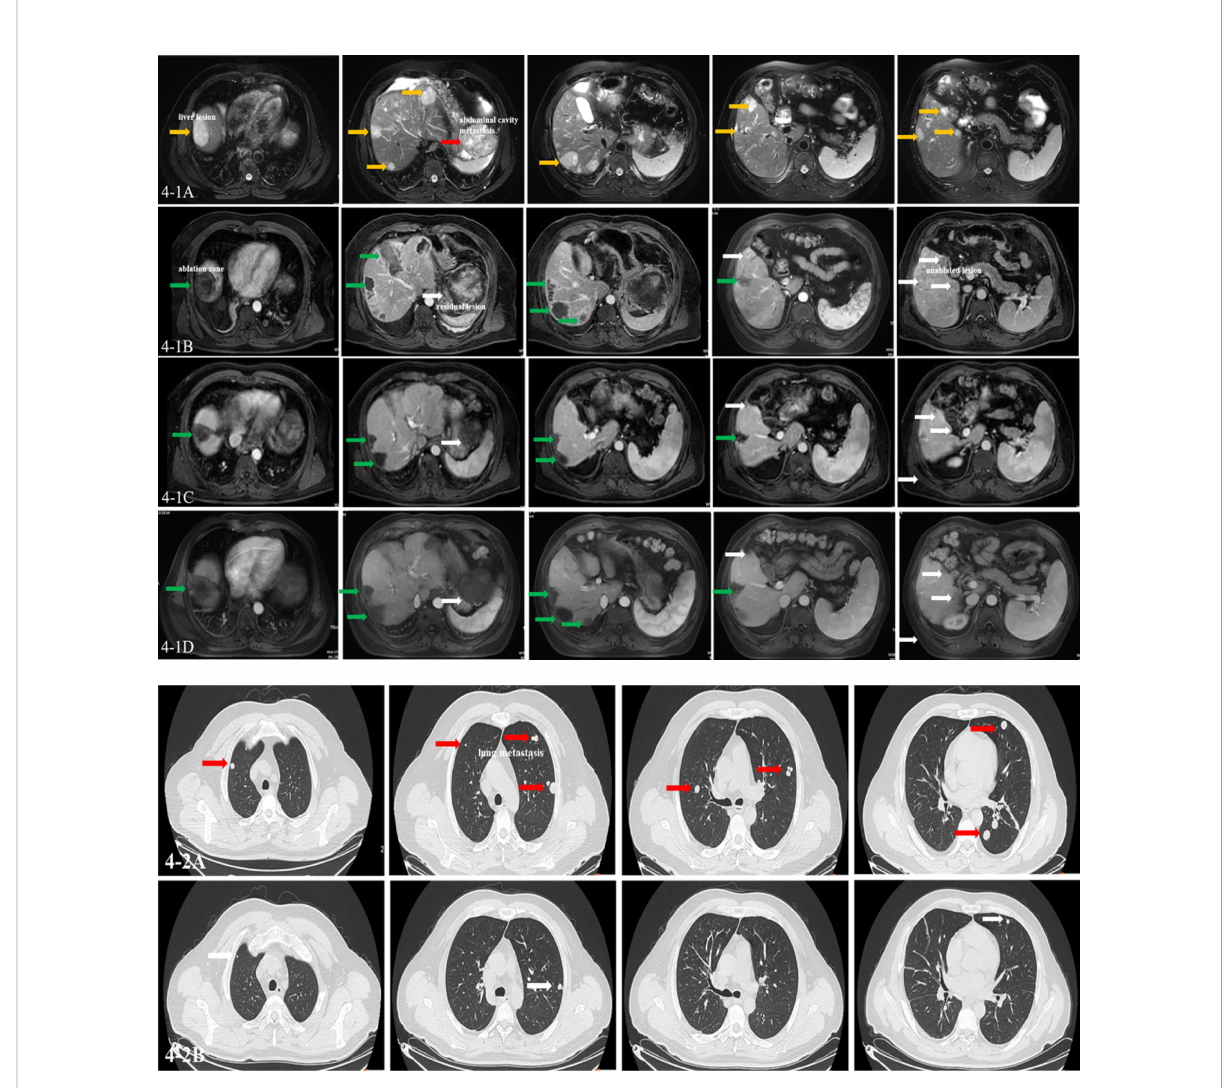
FIGURE 4 Imaging of clinical events. A man aged 45 years was diagnosed as having moderately differentiated hepatocellular carcinoma at Barcelona Clinic of Liver Cancer (BCLC) C stage, who received the combination therapy. (4-1A) The T2 phase of MRI images showing multiple lesions in the liver and abdominal cavity (yellow arrow: liver lesions; red arrow: abdominal cavity metastasis). (4-1B) The arterial phase of MRI images showing multiple ablated zone (green arrow), subtotal ablation of the lesions, and unablated lesion in the liver (white arrow) at baseline. (4-1C, D) The arterial phase of MRI images showing multiple ablated zone (green arrow) with no enhancement and the evaluated lesion shrunken with blood supply reduced (white arrow) after 6 and 12 cycles of combination therapy. The effect was evaluated as partial response (PR) by modi fi ed Response Evaluation Criteria in Solid Tumors (mRECIST). (4-2A) CT images showing multiple metastasis in the lung at baseline (red arrows). (4-2B) CT images showing lung metastasis shrunken obviously and some disappeared after six cycles of combination therapy (white arrow). The effect was evaluated as PR by mRECIST. Until now, the patient is alive with the imaging evaluated as stable disease (SD) lasting for 18